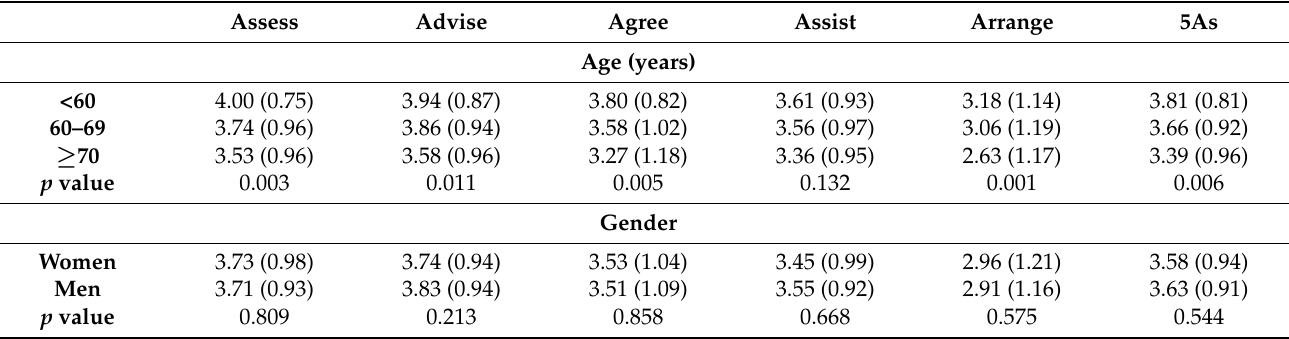
Table 4. The comparison of PACIC+ score according to age and gender. Data are presented as mean (standard deviation).